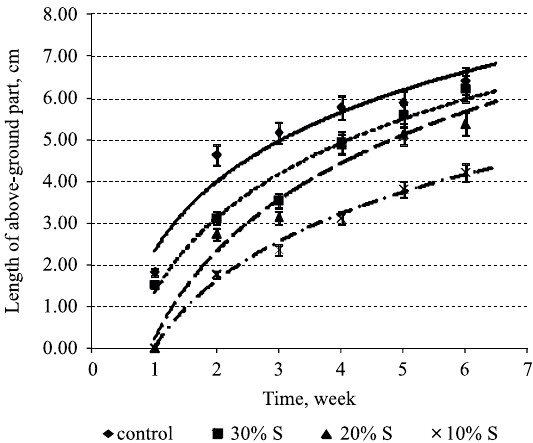
Fig. 9. Length variation of above-ground part of timothy grass